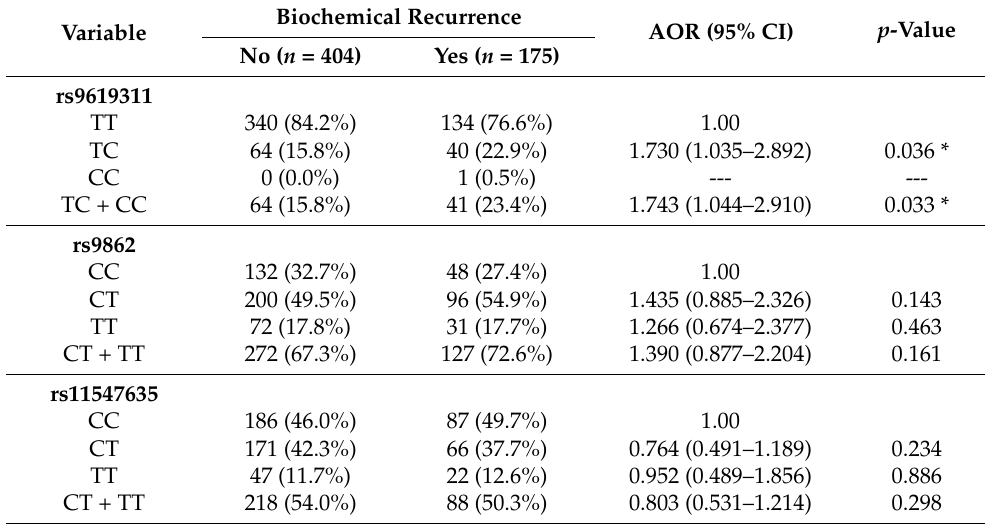
Table 2. Distribution frequency of TIMP3 genotypes in 579 patients with prostate cancer.